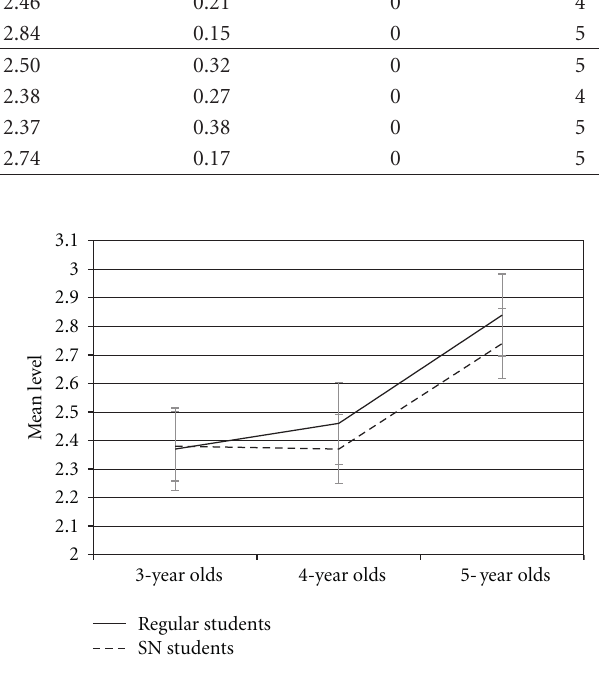
Figure 1: Mean understanding level ( Y -axis) displayed by age X - axis) for each